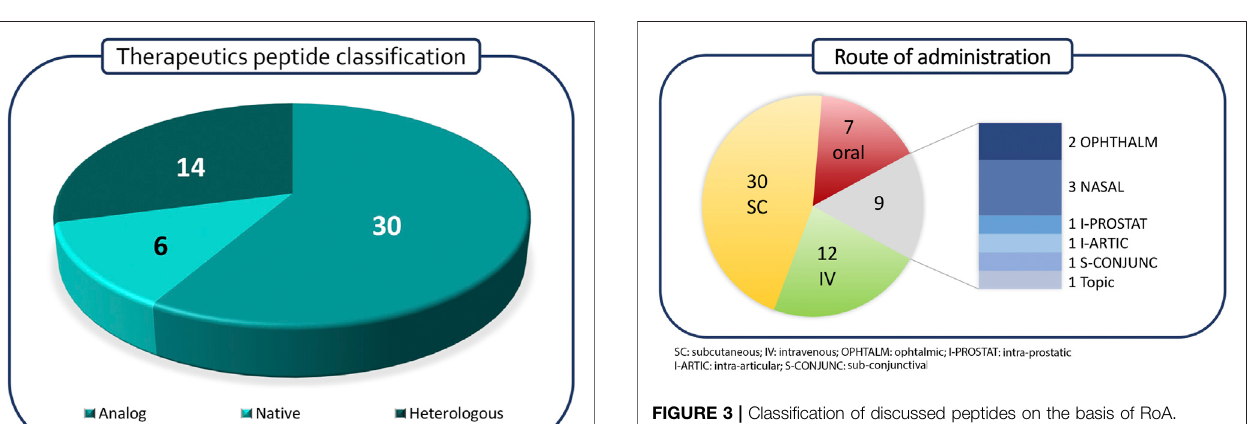
FIGURE 3 | Classi fi cation of discussed peptides on the basis of